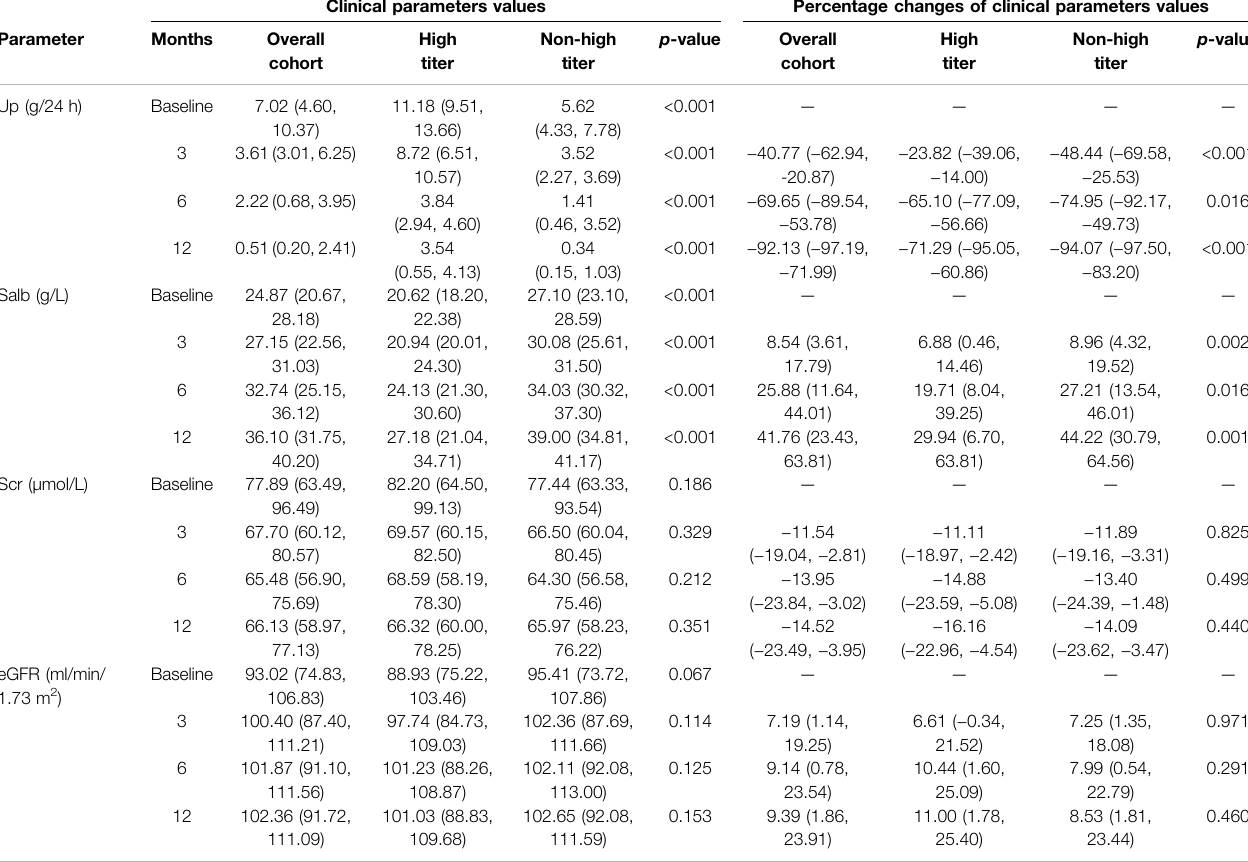
TABLE 5 | The comparison of clinical parameters over